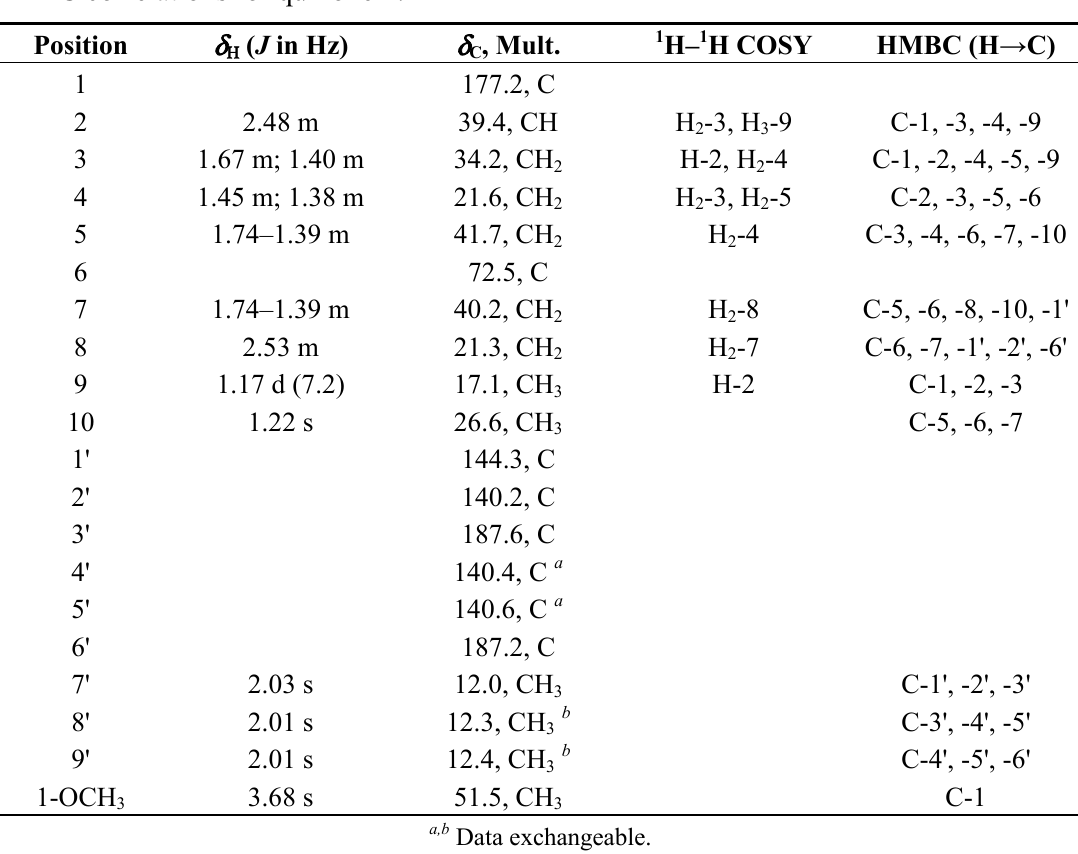
) and 13 C- (100 MHz, CDCl 3